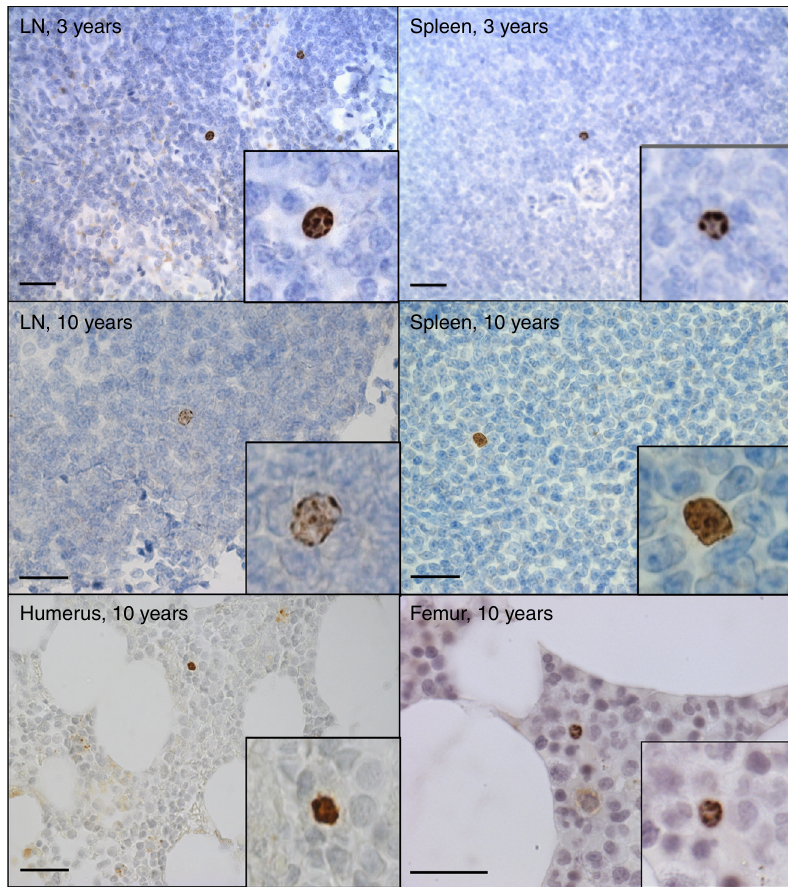
Fig. 4 Identi fi cation of BrdU + plasma cells at 3.5 and 10 years after BrdU administration. Each panel shows a representative microscopic image of tissue samples from rhesus macaques after immunohistochemical staining for BrdU + cells. Paraf fi n-embedded bone marrow and tissue samples were stained for BrdU and counterstained with Mayer ’ s hematoxylin. BrdU + plasma cells were identi fi ed based on their size and their characteristic “ clock face ” nuclei (see inset images). Sections showing draining lymph node (LN) or spleen at 3.5 years after primary vaccination were obtained by surgical removal from experimental CD20-depleted animals (Rh#21139 and Rh#21131, respectively). LN and spleen samples examined at 10 years post-vaccination were obtained from one of the control animals (Rh#20923) whereas sections of humerus and femur came from experimental CD20-depleted animals (Rh#21128 and Rh#21131, respectively) at necropsy. A 20 μ m scale bar is included in each